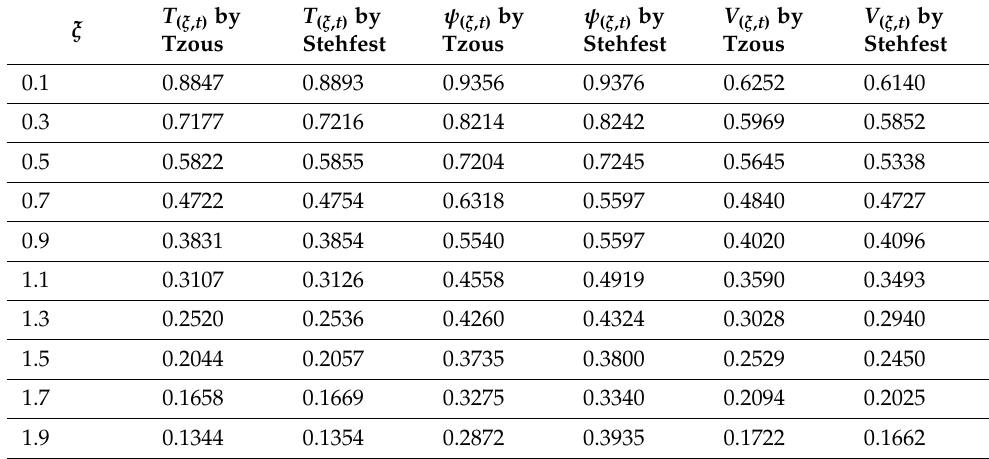
Table 3. Numerical comparison of thermal, concentration, and momentum pro-files.